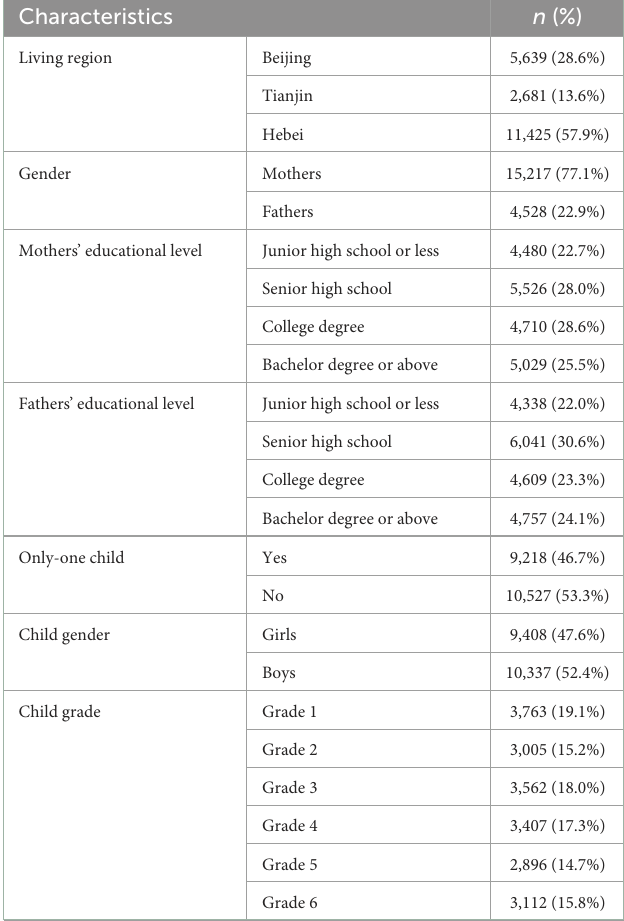
TABLE 1 Characteristics of the parents involved in the study ( N = 19,745).